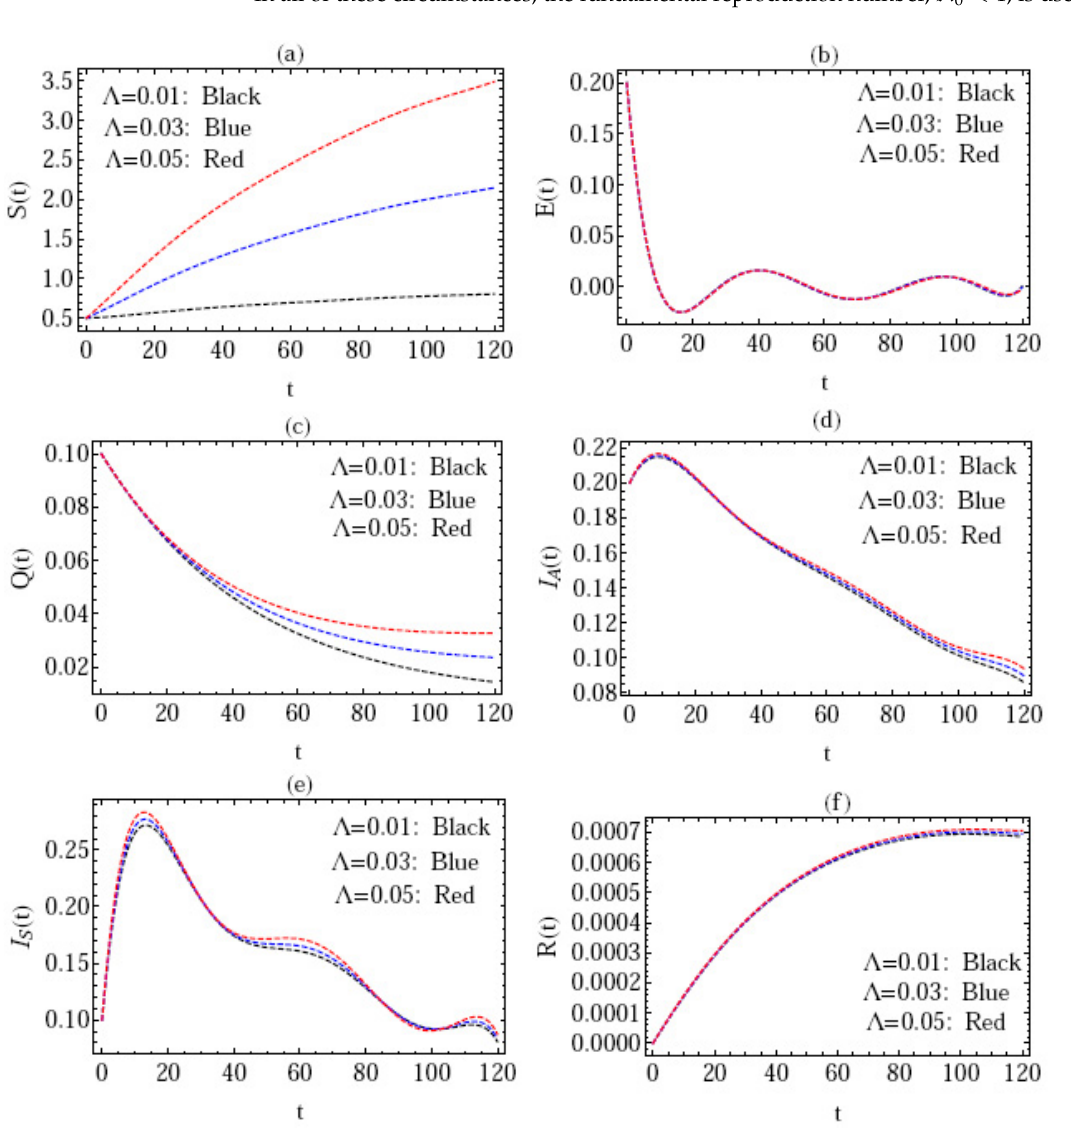
Figure 2. Behavior of the approximate solution via different values of Λ . ( a – f ) S ( t ) , E ( t ) , Q ( t ) , IA ( t ) , IS ( t ) , R ( t )